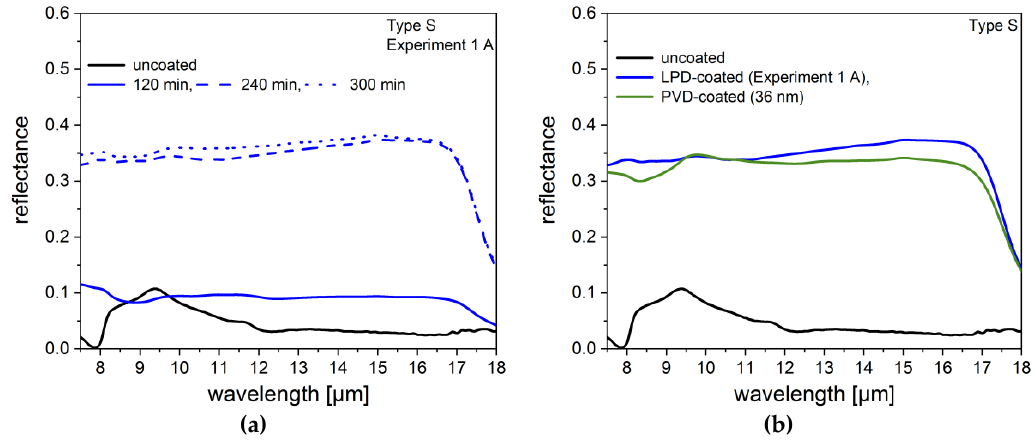
Figure 15 . ( a ): Results of the reflection measurements of the LPD-coated Type S spheres (Experiment 1) with different coating times. Reflection increases with increasing coating time. ( b ): Comparison of the reflectance of LPD-coated (Experiment 1 A, 240 min) and PVD-coated (36 nm) spheres of Type S.